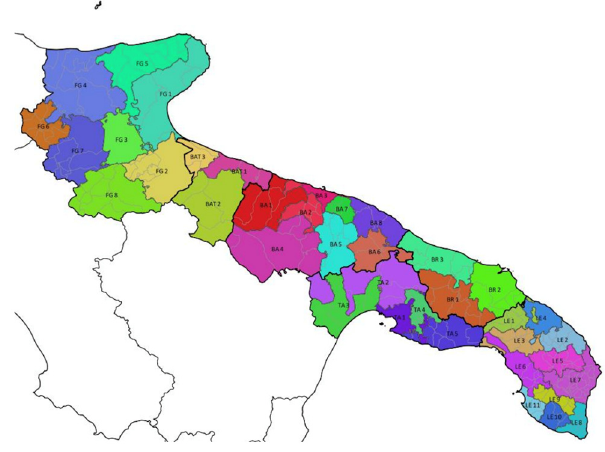
Figure 2. Homogenous areas of municipal solid waste (MSW) management services in Apulia